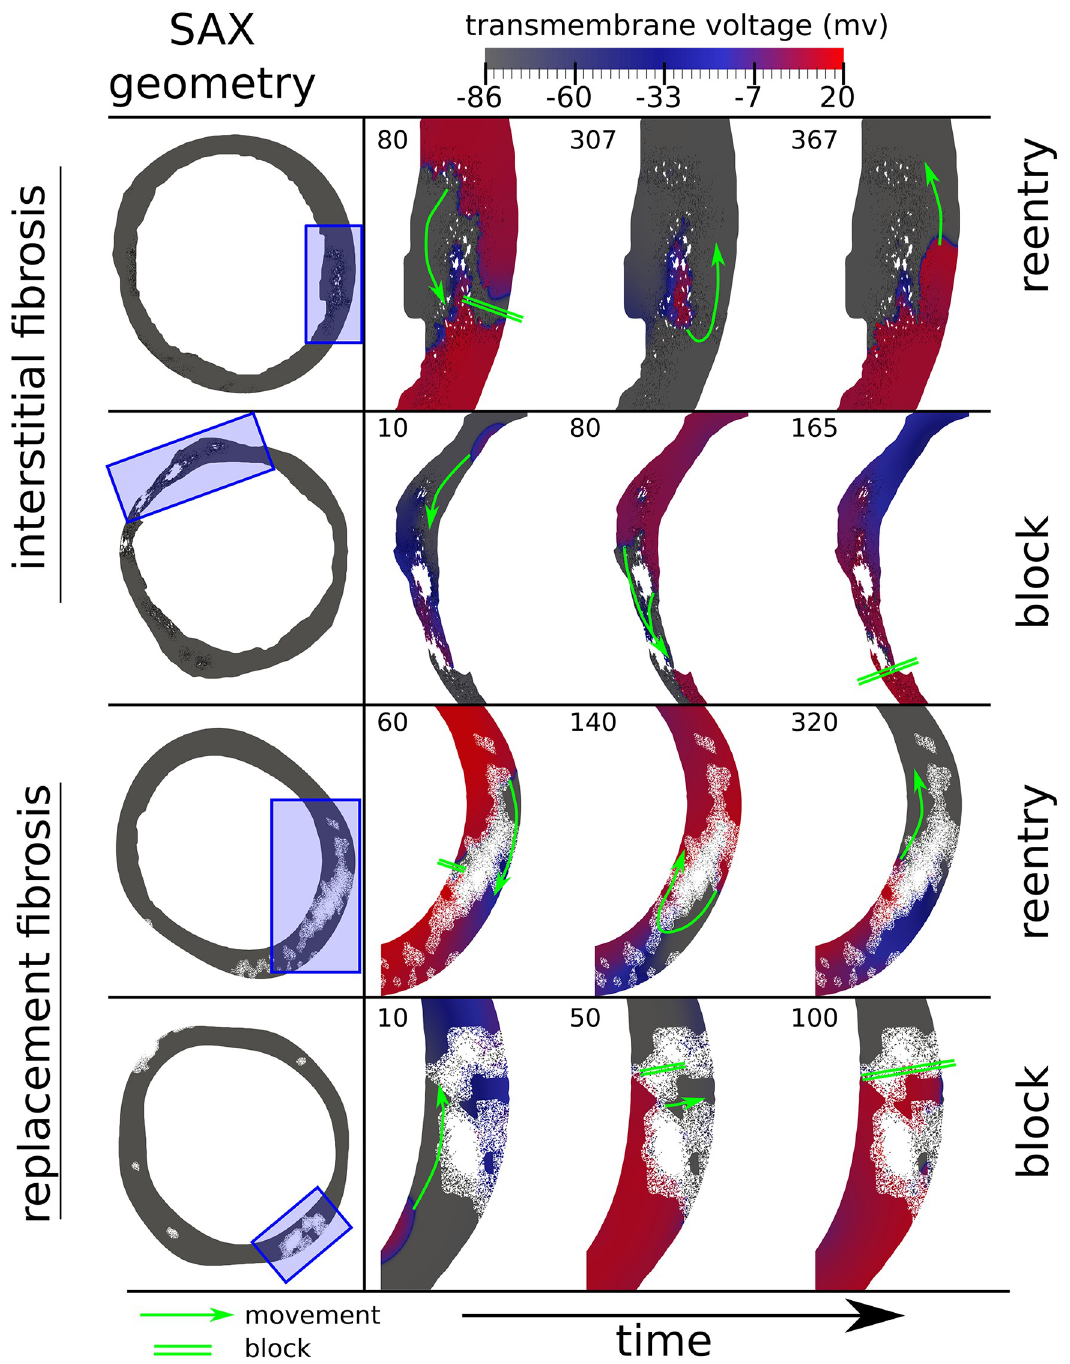
Fig 2. Example instances of transmural reentry and transmural block for simulation models with replacement and interstitial fibrosis based on short axis (SAX) LGE-CMR images. White areas are electrically inert, whereas black lines represent separating edges which current cannot